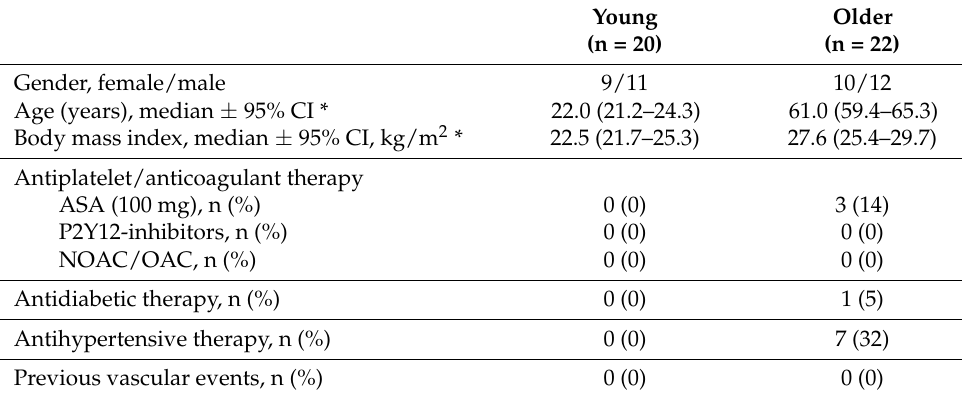
Table 1. Participants’ characteristics. In total, 20 young and 22 older participants performed a sit- to-stand test. ASA, acetylsalicylic acid; NIHSS, National Institute of Health Stroke Scale; NOAC, non-vitamin K antagonist oral anticoagulant; OAC, oral anticoagulation. * p -values were calculated by means of the Mann–Whitney